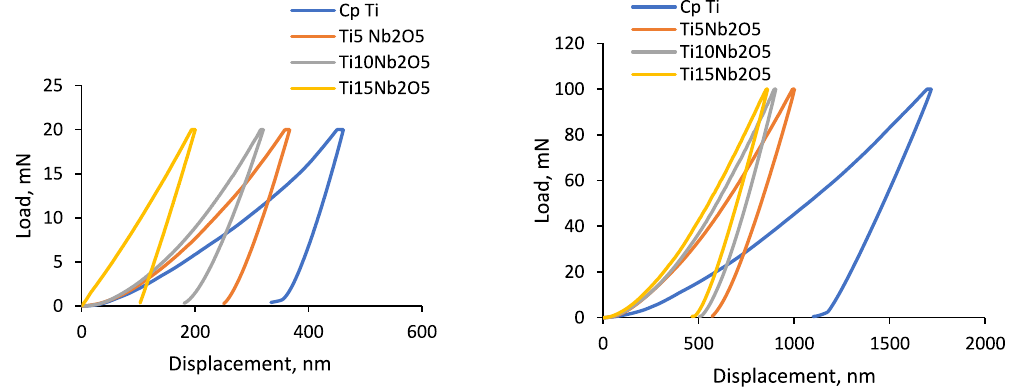
Fig. 3. (a) the load at 20mN (b) the load at 100mN.